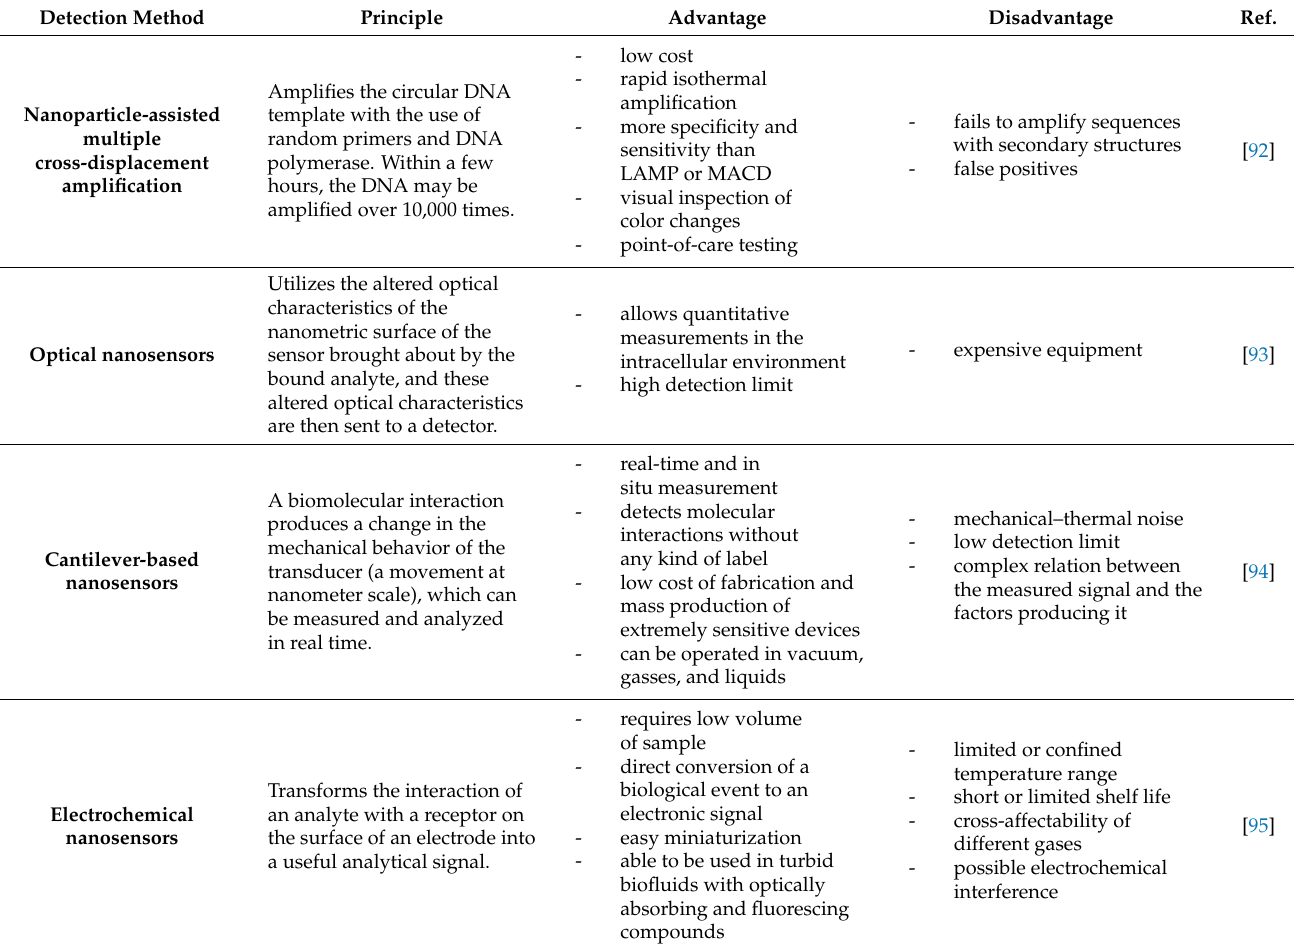
Table 2. Nano-based detection method of K. pneumoniae